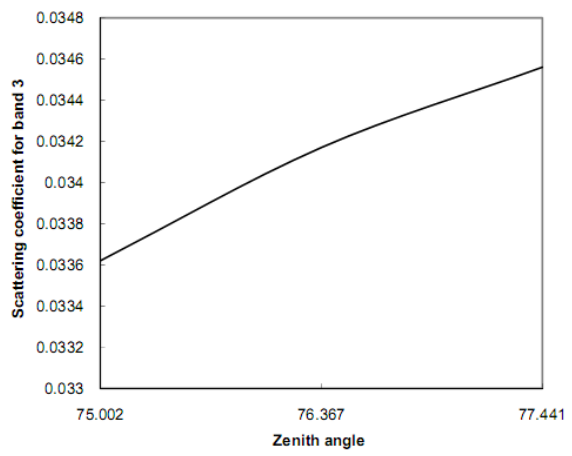
Figure 3. Scattering coefficient versus solar zenith angle for band